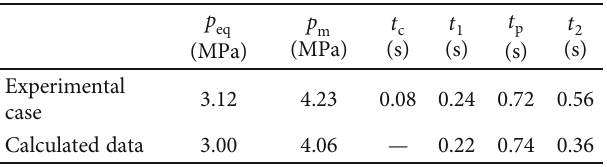
Figure 8: Time histories of the pressure in the combustion chamber for experimental data and calculated result. Table 4: Comparison of internal ballistic parameters between experiment and calculation.